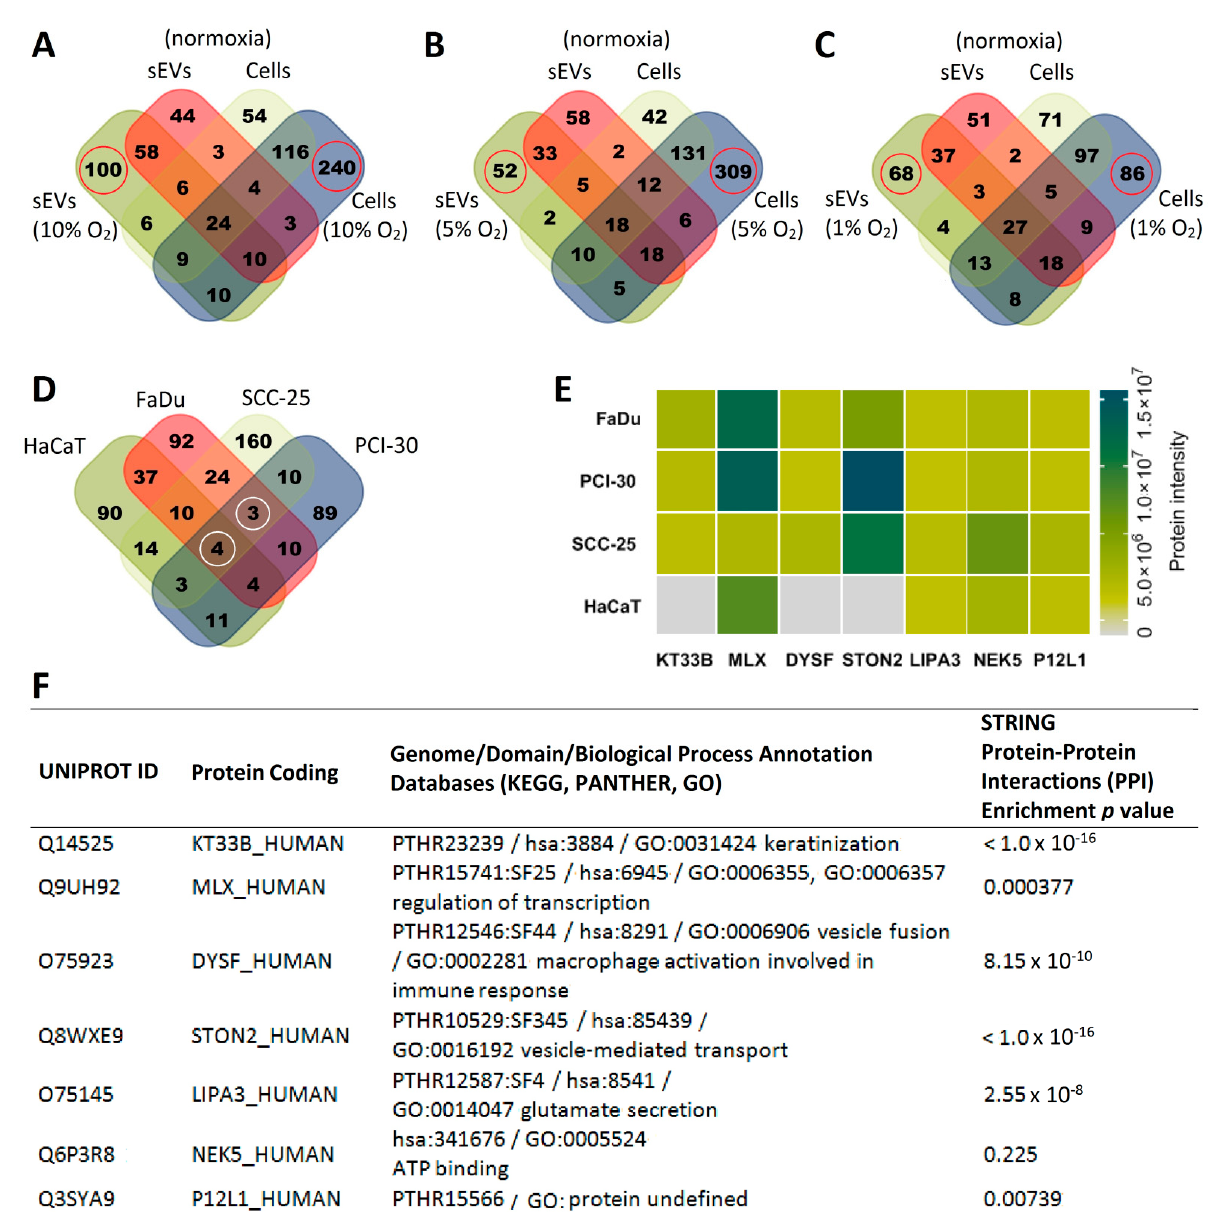
Figure 2. The protein profile of small extracellular vesicles (sEVs) reflects the hypoxic state of Head and Neck Squamous Cell Carcinoma (HNSCC) cells and can be utilized to identify unique hypoxia-related protein signatures in sEVs. The numbers of proteins identified in sEVs reflect the hypoxic state of HNSCC cells. Venn diagrams show numbers of proteins detected in cells cultured in 21% O 2 (normoxia) in comparison to cells and sEVs obtained from supernatants of the cells exposed to ( A ) 10% O 2, ( B ) 5% O 2 , and ( C ) 1% O 2 . ( A – C ) Unique proteins are highlighted by red circles in the Venn diagrams presenting SCC-25 as a representative cell line. ( D ) Proteins detected in sEVs derived from HNSCC cell lines FaDu, PCI-30, and SCC-25 exposed to 10, 5, and 1% O 2 , but absent in 21% were grouped, and shared proteins are presented at the Venn diagram. Seven common proteins were identified (white circles). ( E ) Mean abundance of the 7 common proteins encoded with genes: KT33B (Keratin 33B, Type I), MLX (Max-like protein X), DYSF (Dysferlin), STON2 (Stonin-2), LIPA3 (Liprin-alpha-3), NEK5 (Serine/threonine-protein kinase Nek5), P12L1 (Putative POM121-like protein 1) detected only in hypoxia-derived HNSCC sEVs and Human Keratinocyte (HaCaT)-derived sEVs. ( F ) Information with regards to protein identification number, genome, domain, biological process annotations and protein–protein interactions is based on Universal Protein Resource (UNIPROT), Kyoto Encyclopedia of Genes and Genomes (KEGG), Protein Analysis Through Evolutionary Relationships (PANTHER), Search Tool for the Retrieval of Interacting Genes/Proteins (STRING), and Gene Ontology (GO) classification systems.